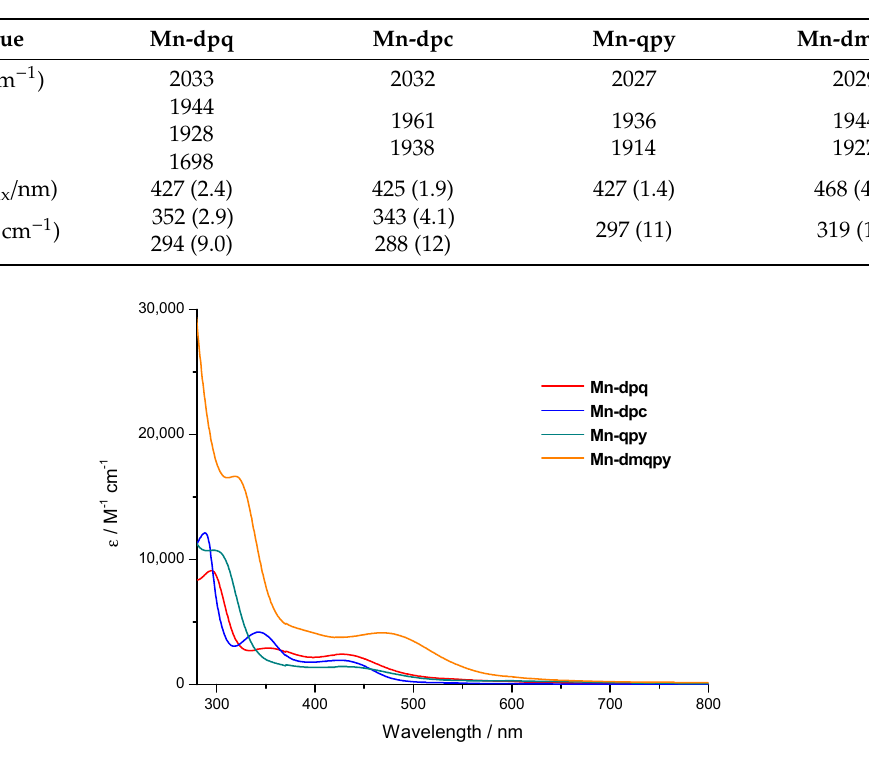
Table 1. Spectral data for the Mn(I) complexes. IR: infrared.